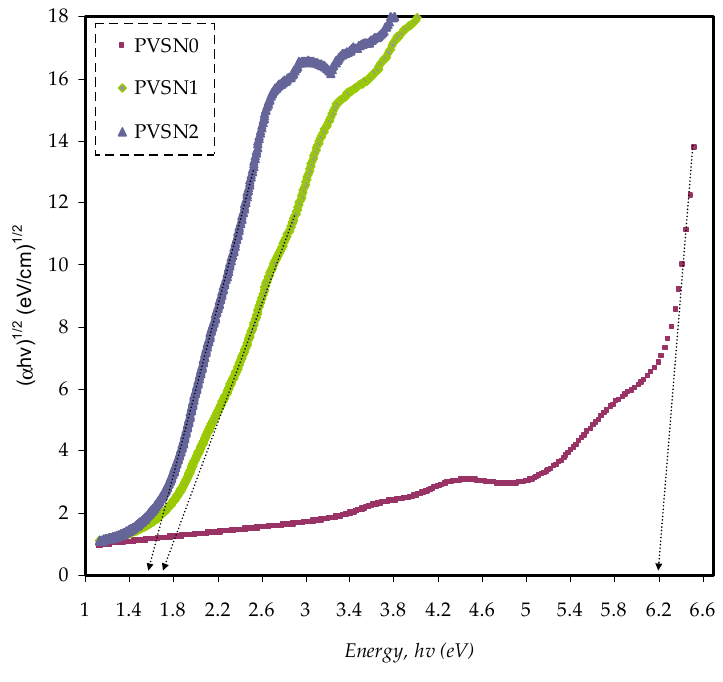
Figure 13. Plot of ( α h υ ) 2/3 vs. h υ for pure PVA and PC films.